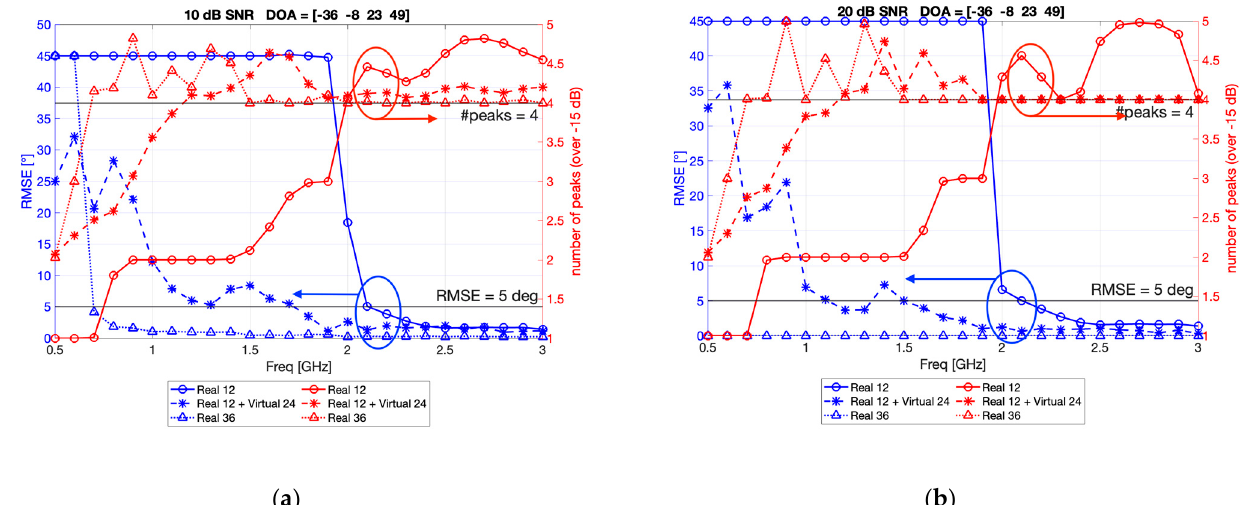
Figure 2. RMSEs from the DOA estimation and the number of peaks when the DOA was − 36, − 8, 23, and 38° under ( a ) 10 dB SNR and ( b ) 20 dB SNR.